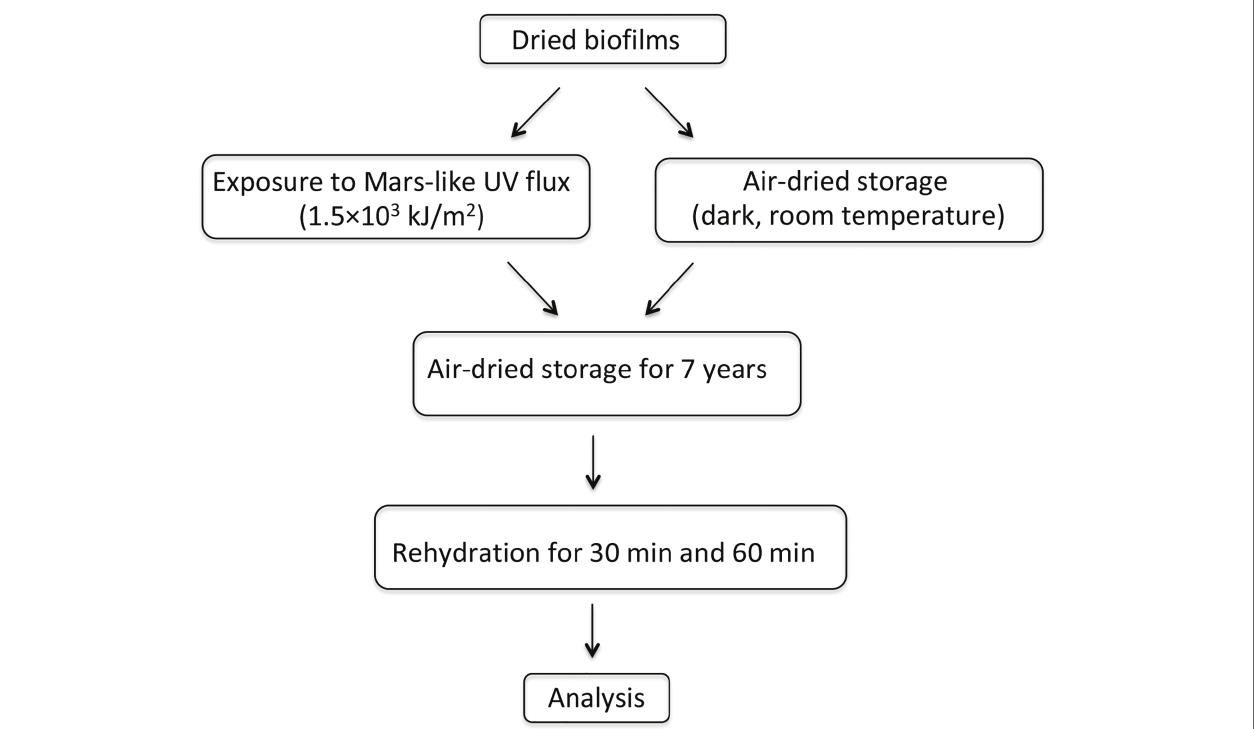
FIGURE 1 | Experimental